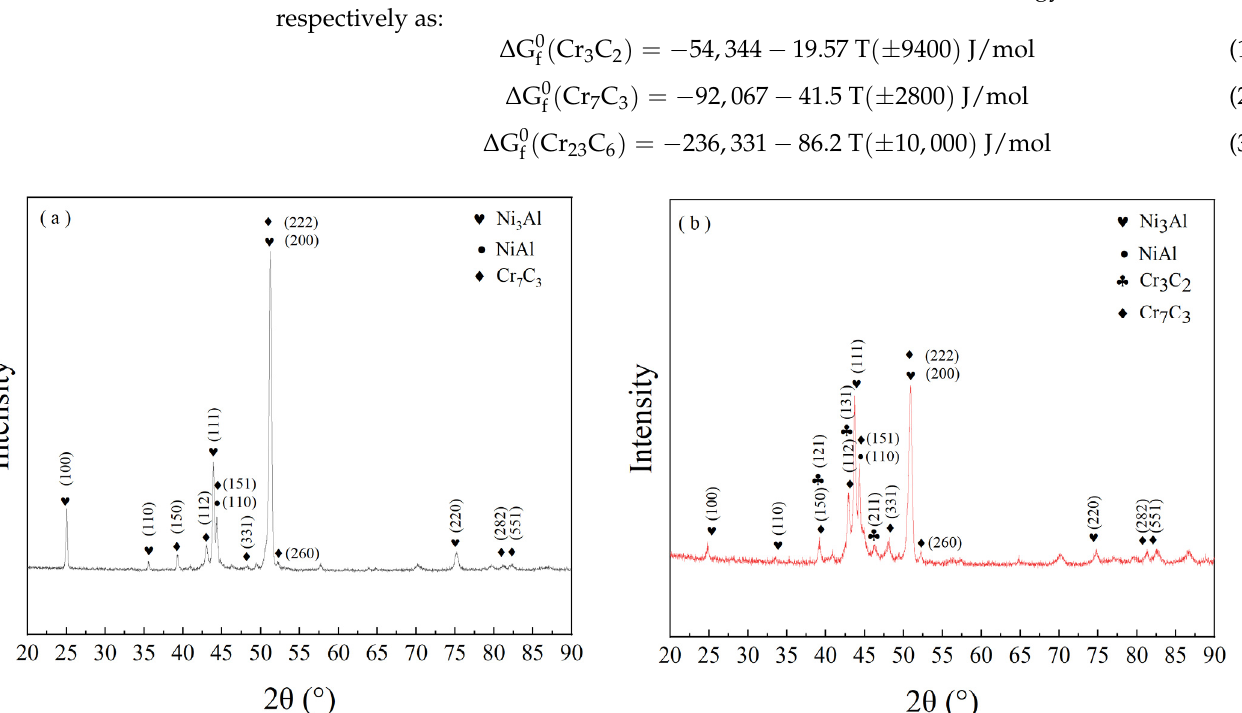
Figure 7. XRD spectra of the two cladding layers: ( a ) the alloyed powder cladding layer; ( b ) the mixed powders cladding layer.